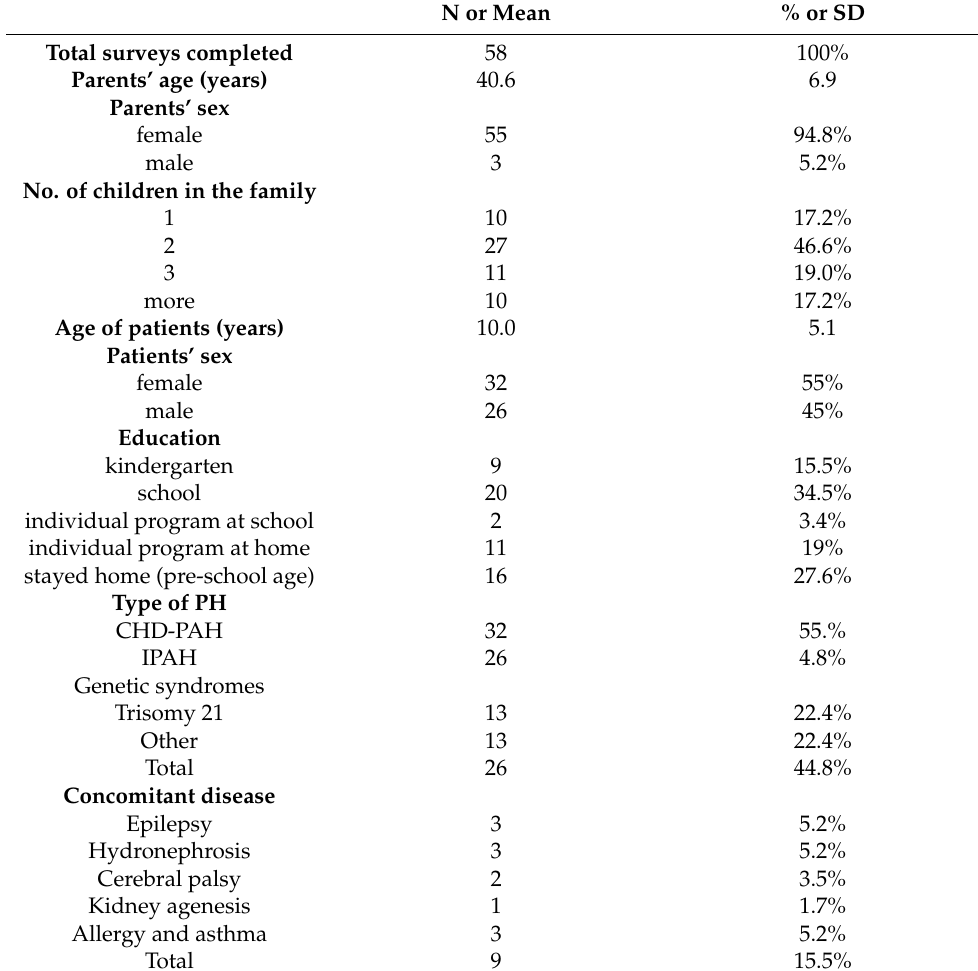
Table 1. Socio-demographic characteristics of the study group. N or Mean % or